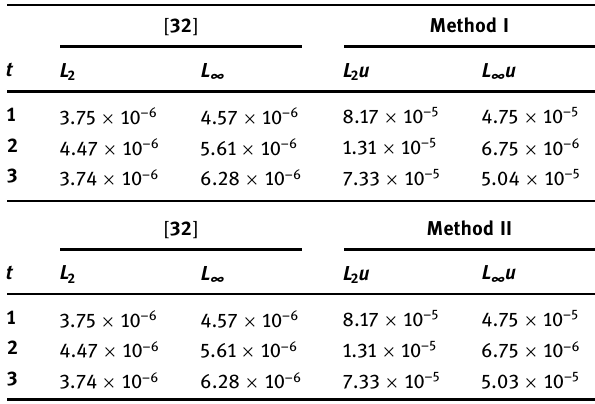
Table 15: Comparison of errors with at = t 1 , 2 and 3 for = N 21 , = t Δ 0.0001 , and = τ 0.5 regarding Example